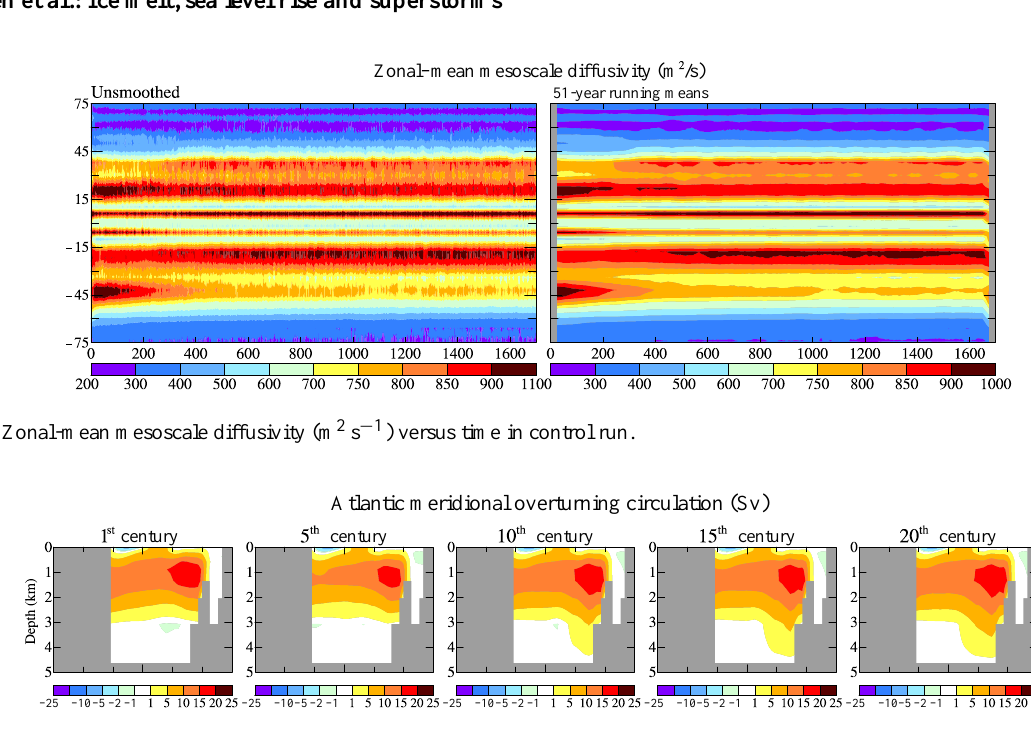
Figure 2. AMOC (Sv) in the 1st, 5th, 10th, 15th and 20th centuries of the control